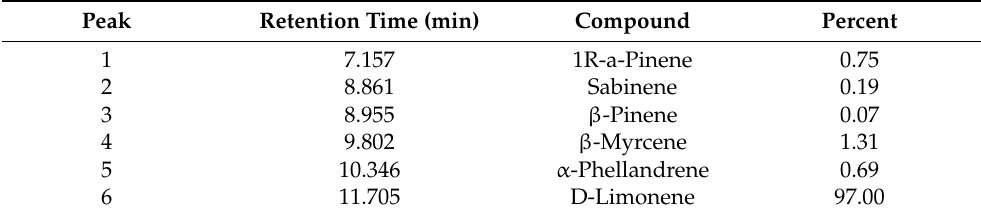
Table 8. Chemical composition of pomelo essential oil extracted by steam